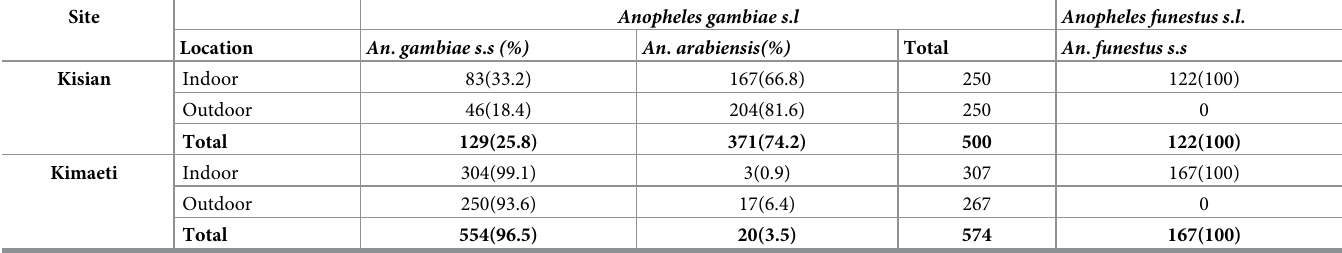
Table 1. An . gambiae s . l . and An . funestus s . l . species composition from indoor and outdoor resting collections from Western